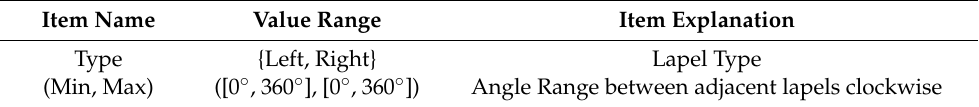
Table 2. Node contents of the